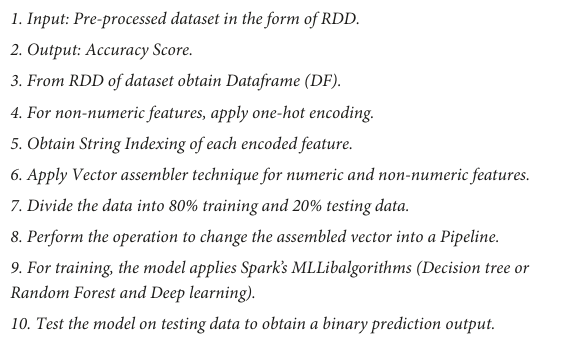
ALGORITHM 1 Spark distributed KNN